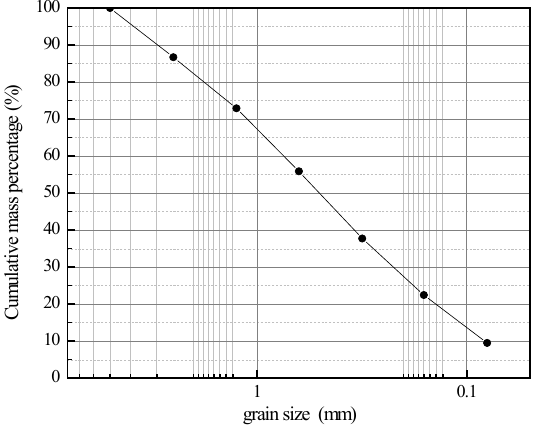
Figure 1. Grading curves. Table 2. Chemical composition of ordinary Portland cement.